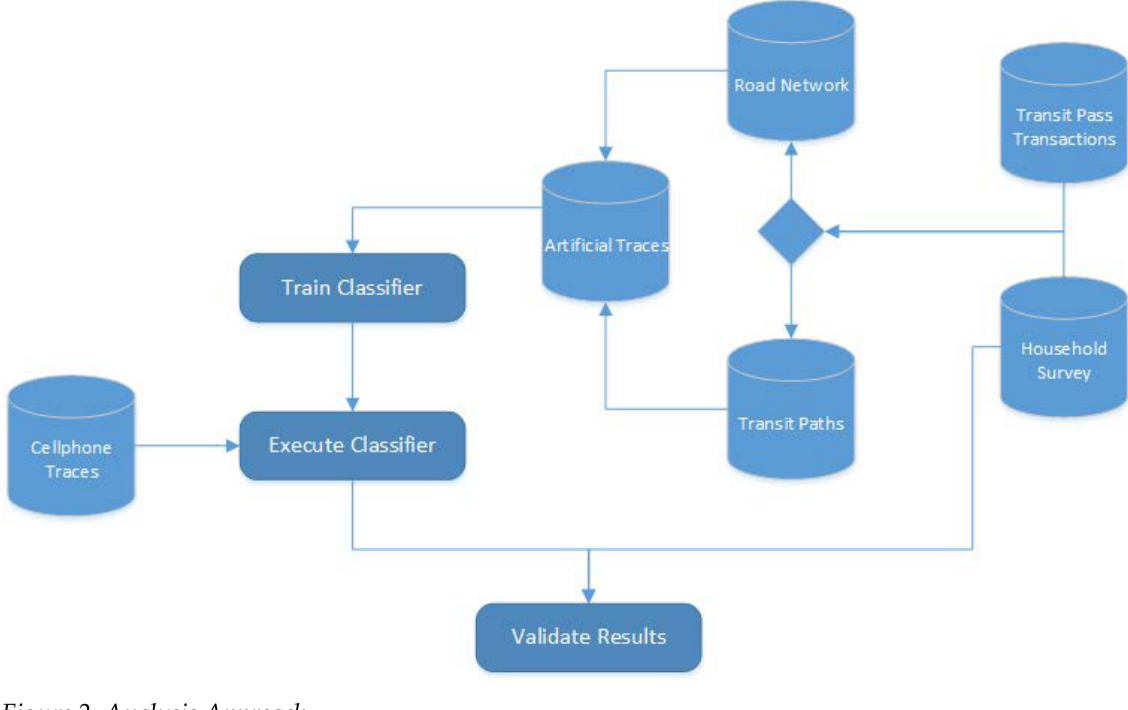
Figure 2. Analysis